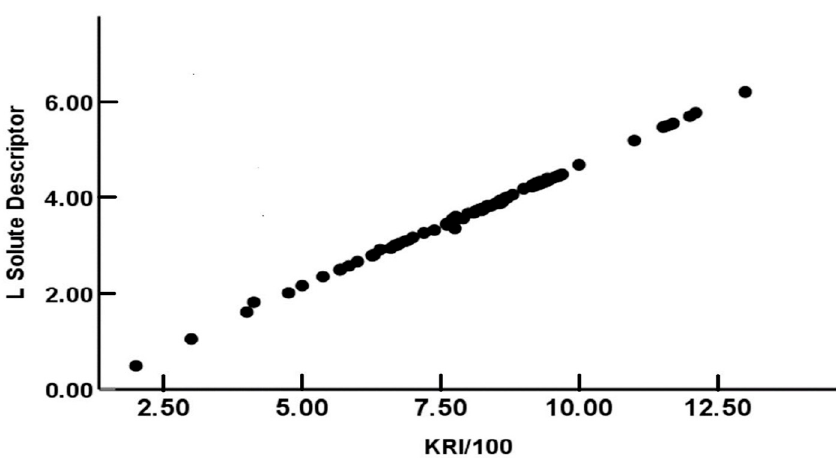
Figure 1. Comparison of the experimental-based L -solute descriptors in our database and back-calculated values based on Equation (10).